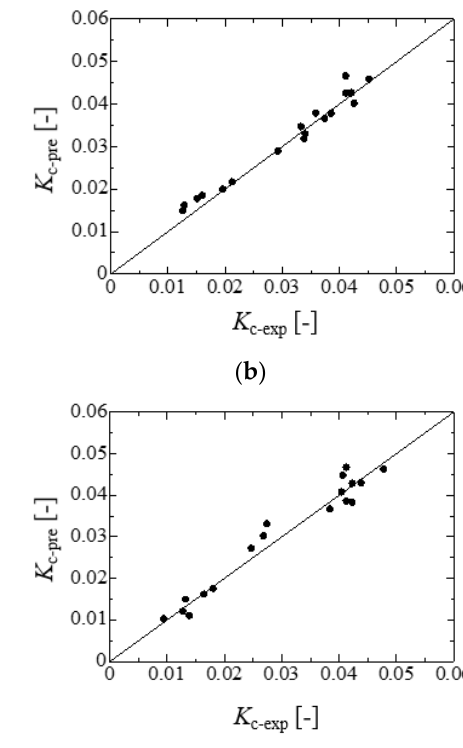
Table 3. Values for cos